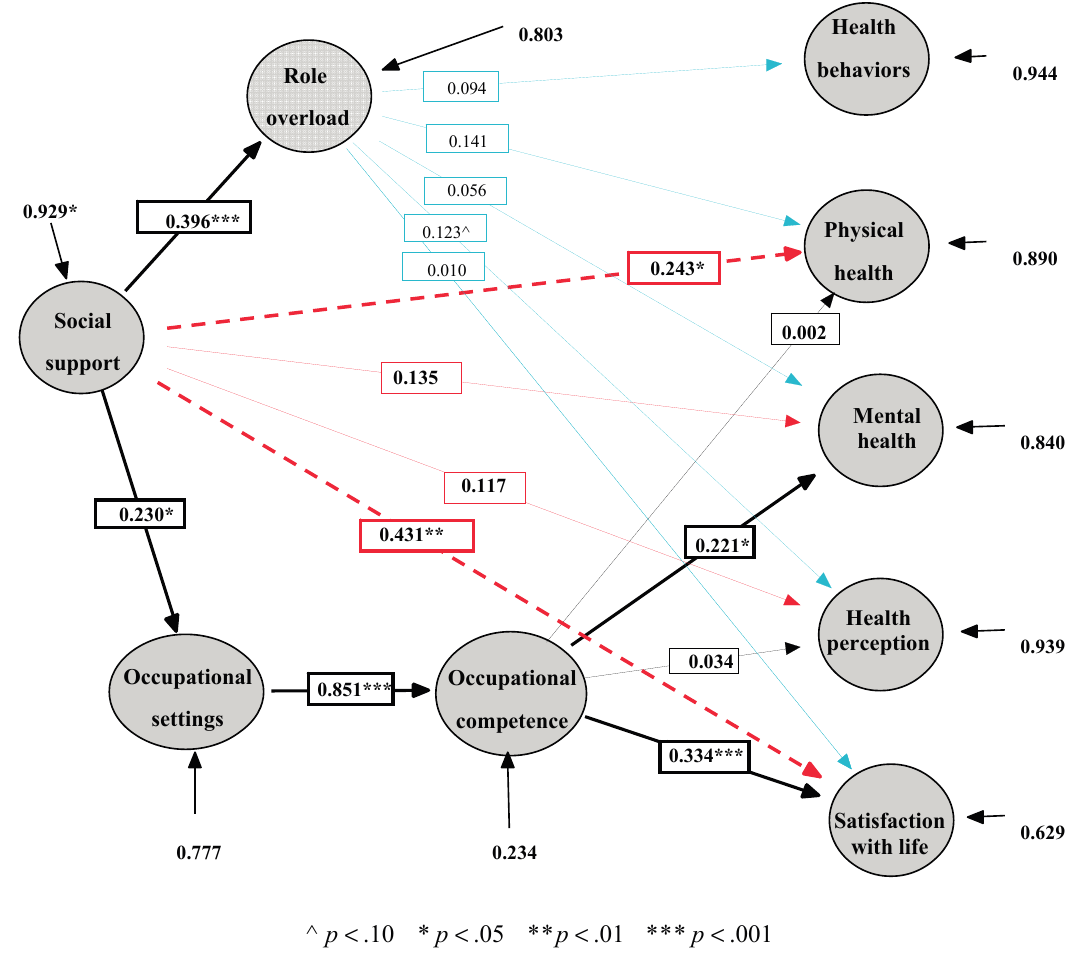
Figure 2. Parameter estimates in the three models (N = 150). Figure 2 shows standards estimates. The value at the beginning of an external line indicates standard error variance (percentage of unexplained variance in the endogenous variable). The bright line indicates that the effect is not significant. Black lines describe Model I, dotted red lines describe the additional effects in Model II, and blue lines describe the additional effects in Model